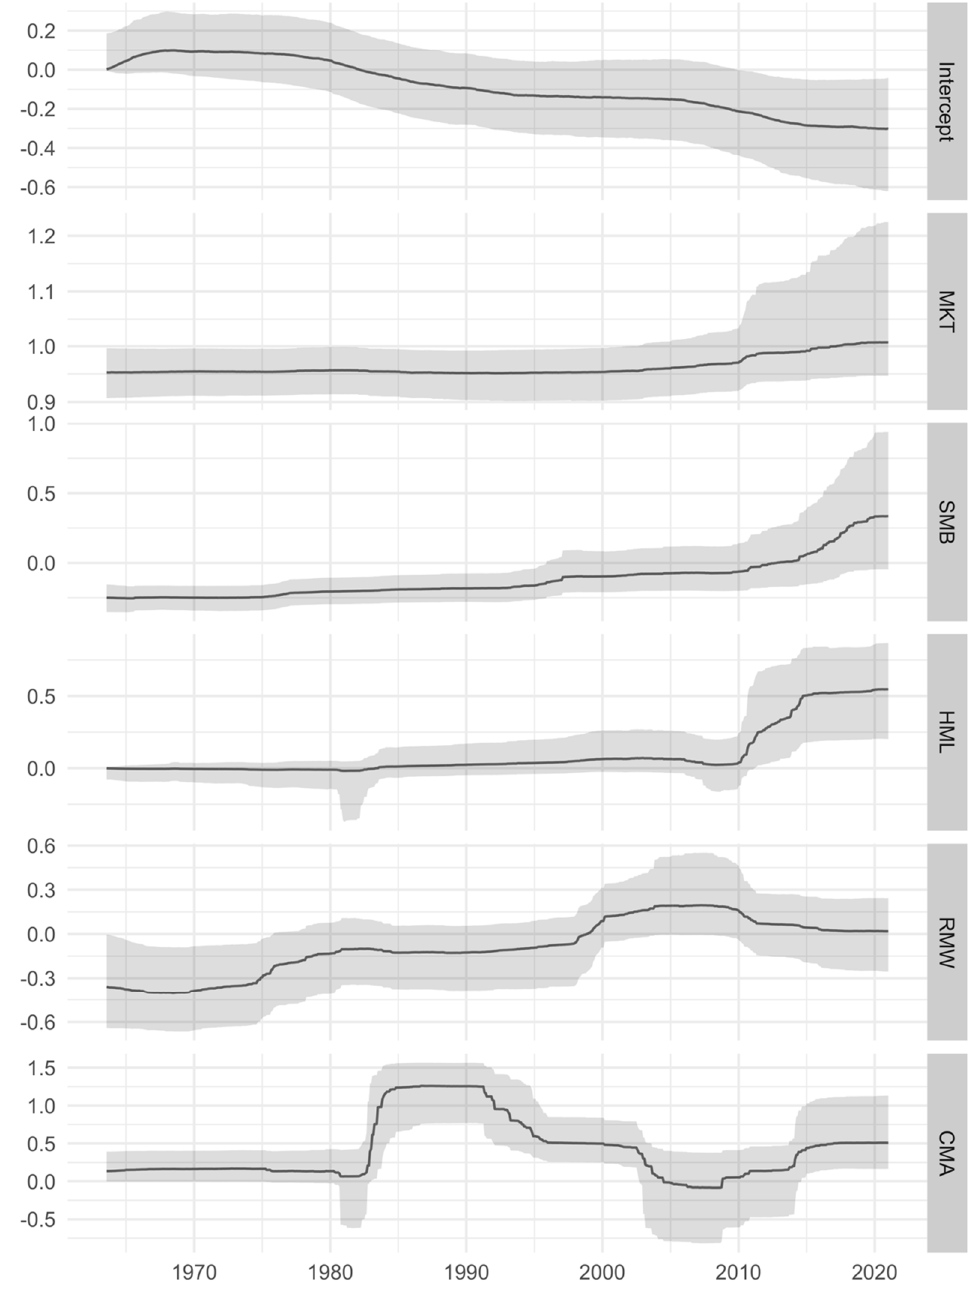
Figure 4. Threshold time-varying parameter beta estimates—Energy. Note: The figure presents the plots for the posterior medians (solid line) with 68% confidence bands (gray shaded region) of the time varying beta estimates from the TTVP model with stochastic volatility. Gibbs sampling is used with 10,000 posterior and 10,000 burn-in draws. MKT, SMB, HML, RMW and CMA represent the Market, Size, Book-to-Market, Profitability and Investment factors based on the five-factor specification of Fama and French [57].